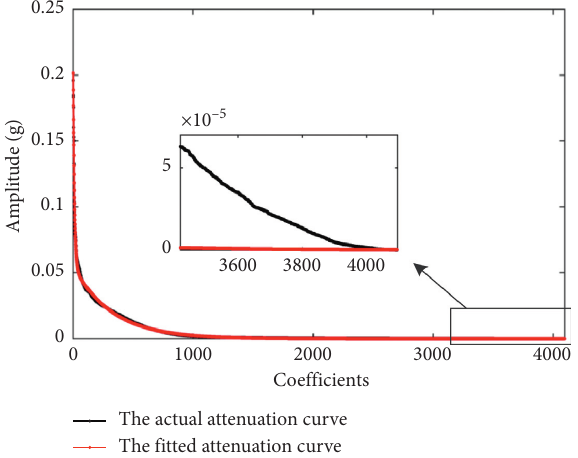
Figure 11: The fitting result of coefficient attenuation curve in Figure 10(b): SSE � 0.007; R-square �